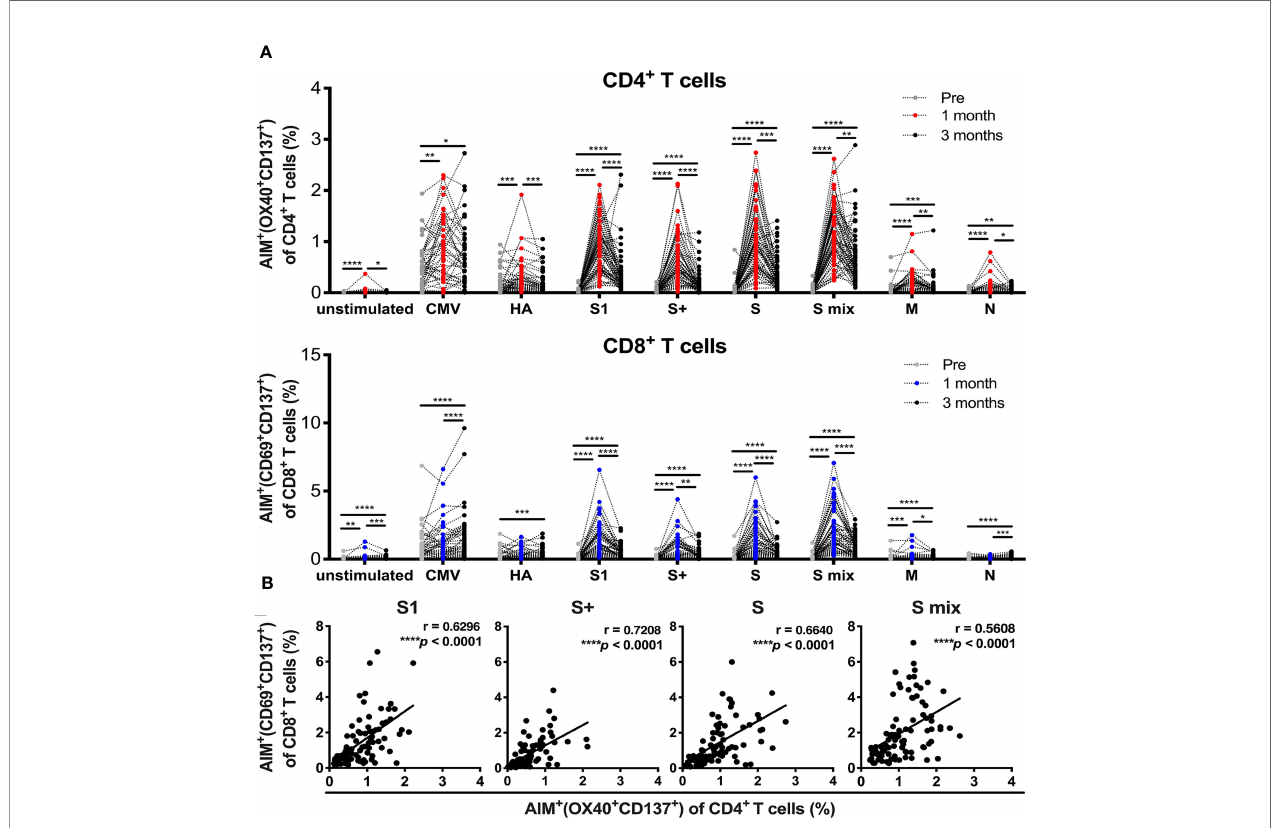
FIGURE 1 | SARS-CoV-2 mRNA vaccination-induced T cell responses. Activation-induced marker (AIM) assays were performed with samples obtained from individuals pre-, and 1 and 3 months post-vaccination. Peripheral blood mononuclear cells were stimulated with peptide pools of SARS-CoV-2 structural protein, cytomegalovirus pp65 protein, and in fl uenza A virus hemagglutinin (HA). Twenty-two hours later, T cells responding to the indicated peptide pools were measured as AIM + (OX40 + CD137 + ) CD4 + T cells and AIM + (CD69 + CD137 + ) CD8 + T cells by fl ow cytometry (FACS). (A) Percentages of AIM + (OX40 + CD137 + ) cells in CD4+ T cells and AIM + (CD69 + CD137 + ) cells in CD8 + T cells at pre-, and 1 and 3 months post-vaccination. (B) The correlation between AIM + (OX40 + CD137 + ) CD4 + T cells and AIM + (CD69 + CD137 + ) CD8 + T cells at 1 month post-vaccination. CMV, cytomegalovirus pp 65 protein; HA, in fl uenza A virus hemagglutinin, S, parts of S1 and S2 domains of SARS-COV-2 spike; S1, SARS-COV-2 spike S1 domain; S+, parts of the S2 domain of SARS-COV-2 spike, S mix, a mixture of S, S1, and S+; M, SARS-COV-2 membrane; N, SARS-COV-2 nucleocapsid. Each dot indicates the value of one individual. (A) Statistical differences between groups of pre-, 1 and 3 months were analyzed by the Friedman test. *p < 0.05, **p < 0.01, ***p < 0.001, ****p < 0.0001. (B) Correlations were analyzed using Spearman ’ s correlation